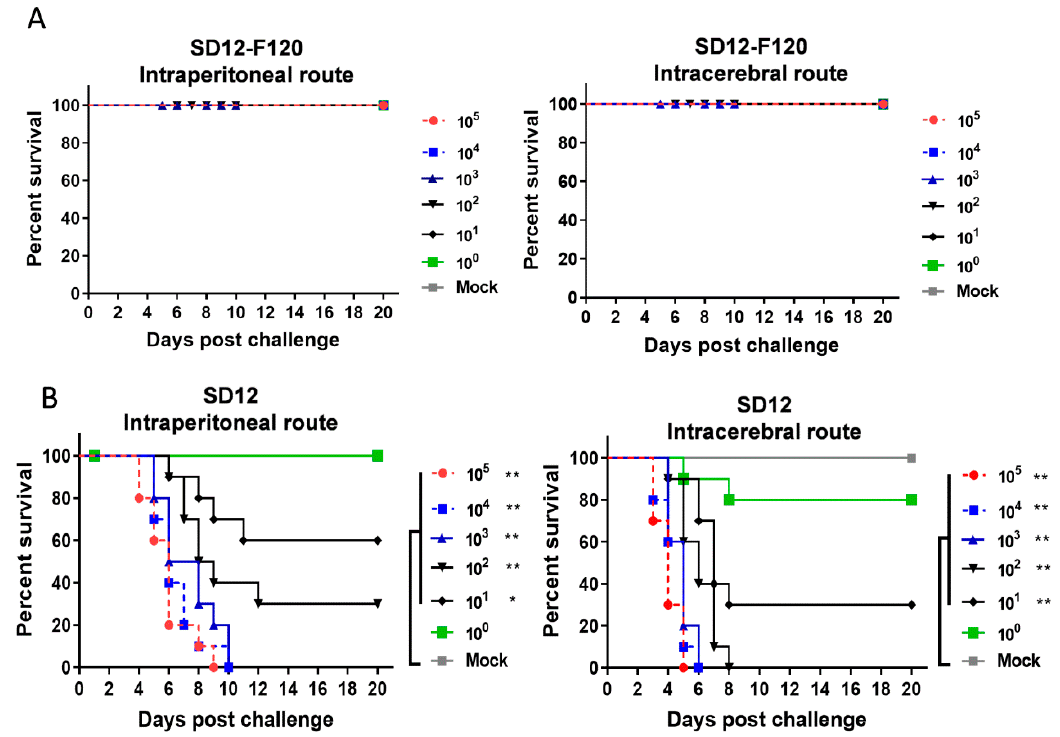
Figure 3. Neuroinvasiveness and neurovirulence tests in mice. Mice (10 mice / group) were inoculated intraperitoneally or intracerebrally with either SD12-F120 ( A ) or SD12 ( B ) at doses ranging from 10 0 to 10 6 PFU to measure neuroinvasiveness or neurovirulence, respectively. The mice were monitored daily for 20 days. Kaplan–Meier test was used for survival analysis. Asterisks indicate values that are statistically significant (* p < 0.05; ** p <0.01).